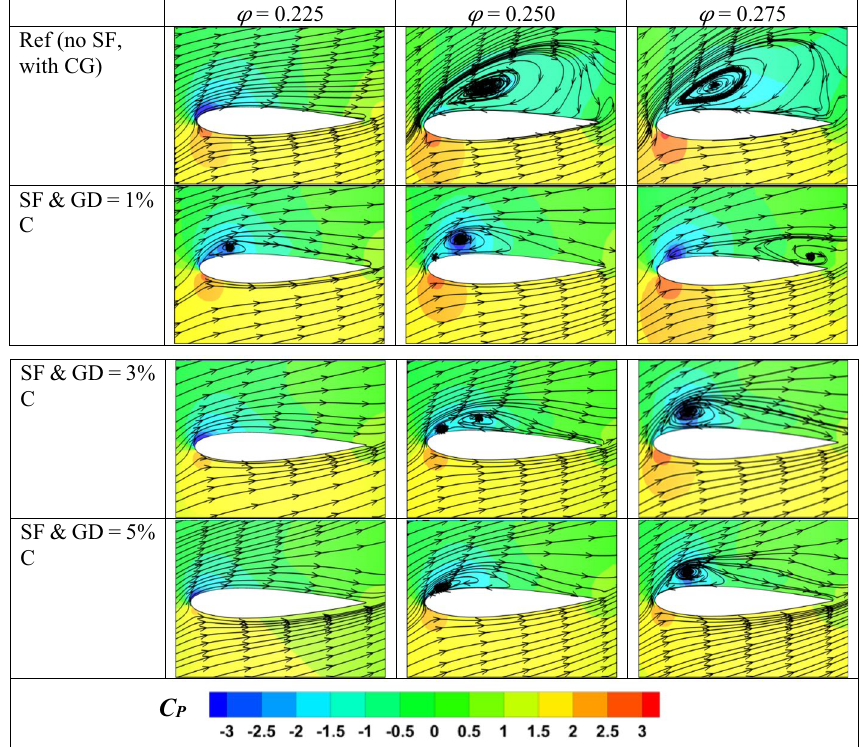
Figure 10. Pressure contours and streamlines near SF at 80% blade